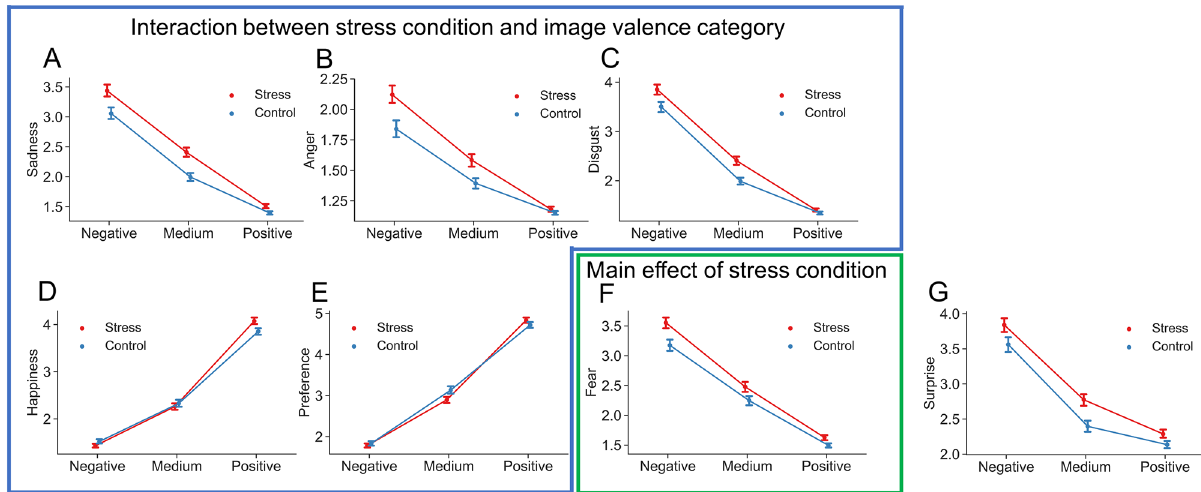
Figure 3. Plot of evaluation scores for valence assigned to images (negative, medium, positive) in stress (red) and control (blue) conditions. Sadness, anger, disgust, preference, and happiness showed significant valence × condition interactions (F (2,40) = 9.06, P < 0.001; F (2,40) = 2.82, P < 0.05; F (2,40) = 4.99, P < 0.01; F (2,40) = 3.81, P < 0.05; F (2,40) = 6.24, P < 0.01, respectively, in two-way repeated measures ANOVA). Evaluations of fear and surprise did not reveal a valence × condition interaction, but fear showed a main effect of condition (F (2,20) = 7.89, P = 0.011). Error bars indicate the